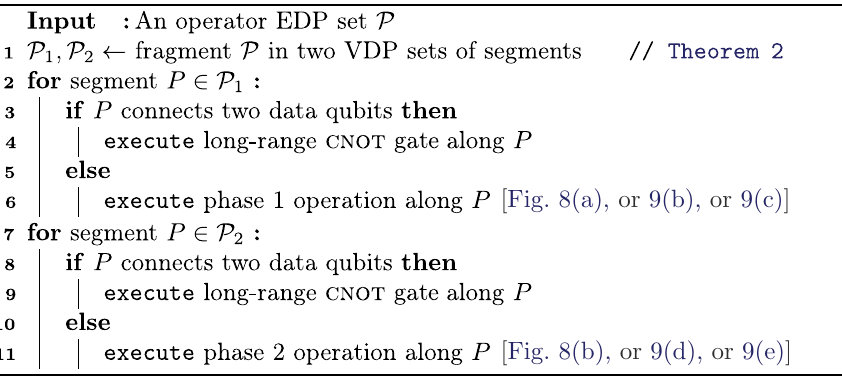
Algorithm 1. EDP subroutine : to apply CNOT s to the data qubits at the endpoints of a set of edge-disjoint paths P , where the interior of each path is supported on ancilla qubits. The depth is at most